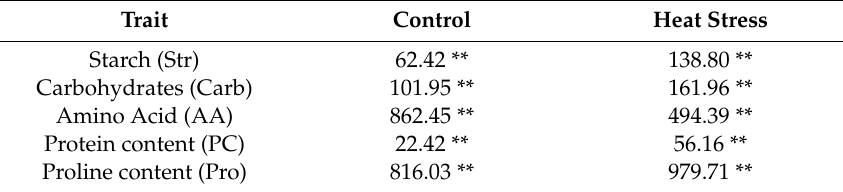
Table 2. Analysis of variation ( F -values among genotypes) for all physiological traits scored on the barley population under control and heat stress